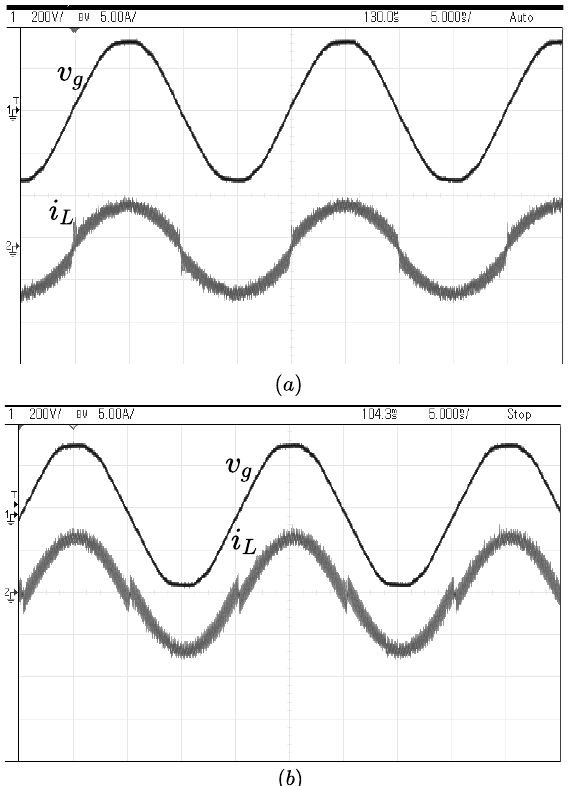
Figure 22. Inductor current obtained with ( a ) Sinusoidal i L ∗ ( b ) Over-corrected i L ∗